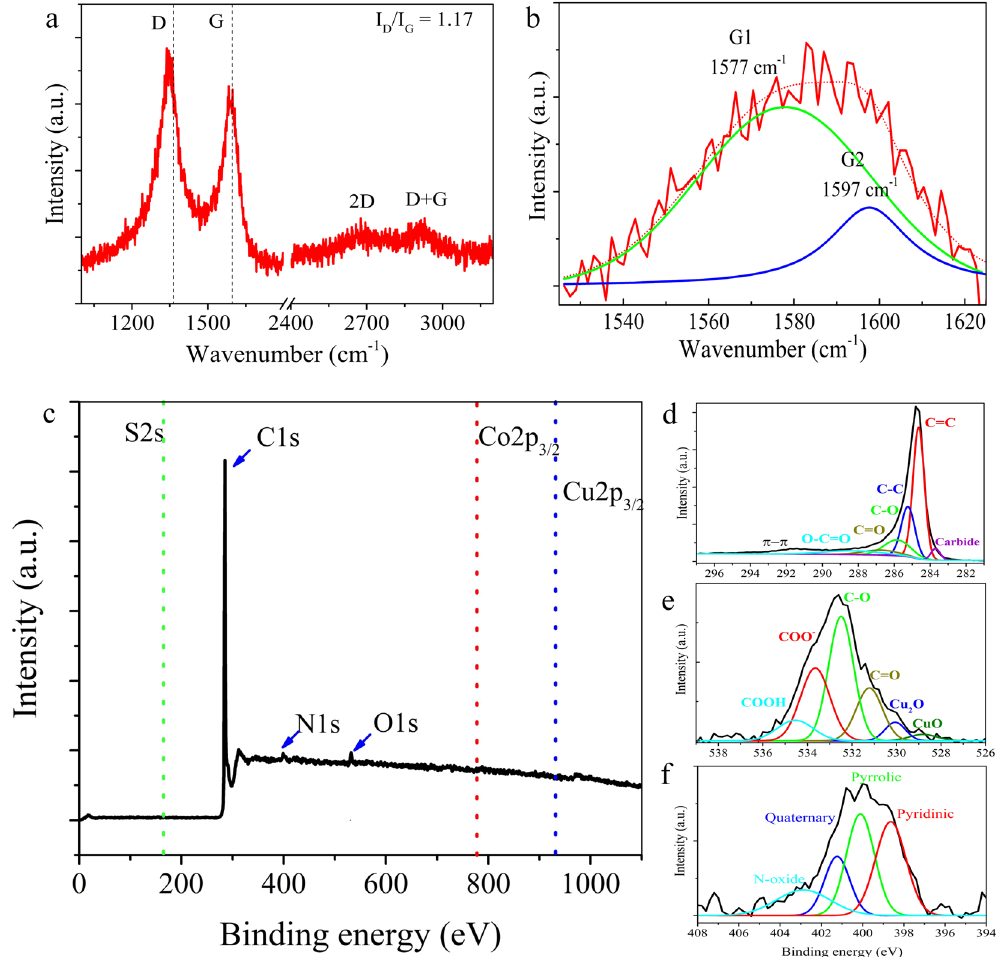
Figure 5. ( a ) Raman shift of N-CBs. The intensity ratio of the D-Raman and G-Raman peaks (I D /I G ) are indicated. ( b ) Deconvolution analysis of the G-Raman peak showing the presence of two peaks (G1 peak placed at 1577 cm − 1 and G2 peak at 1597 cm − 1 ). ( c ) XPS survey scans revealing N, C, O, and S. ( d–f ) Deconvoluted XPS spectra. ( d ) C1s spectra indicating sp 2 hybridized carbons (C = C), sp 3 hybridized carbons (C-C), and C = O, C-O, COO − , and metal carbide compounds. ( e ) O1s spectra show Cu(II), Cu(I) oxide, COO − , C = O, and C-O bonds. ( f ) N1s spectra present the N-pyridinic, N-pyrrolic, N-quaternary, and pyridine-oxide. Binding energies are indicated in Table S1 (Supplementary